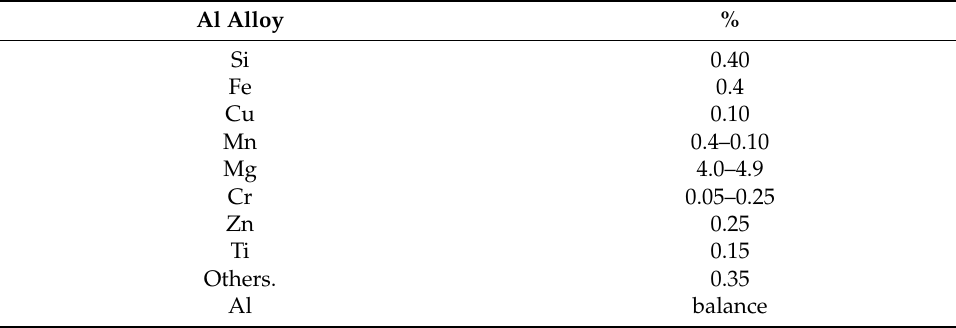
Table 3. Chemical composition of aluminum alloy AW 5083